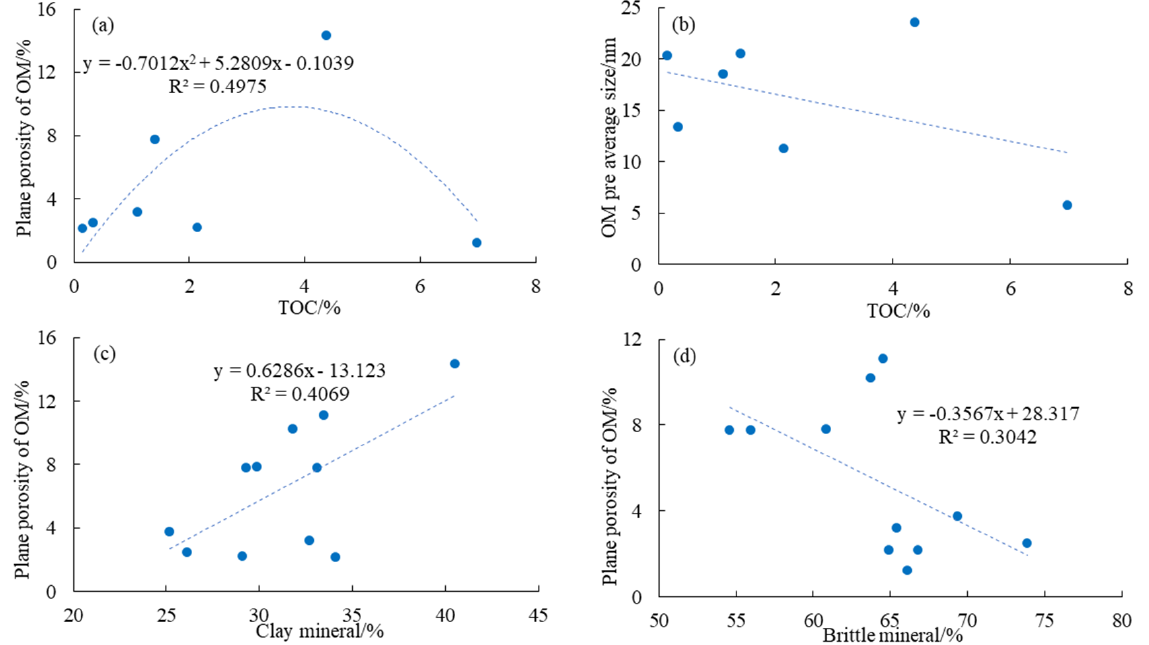
Figure 18. Relationship between TOC ( a , b ), clay mineral contents ( c ), brittle mineral contents ( d ) and OM pore of the Lower Paleozoic shale from the upper Yangtze Plate.